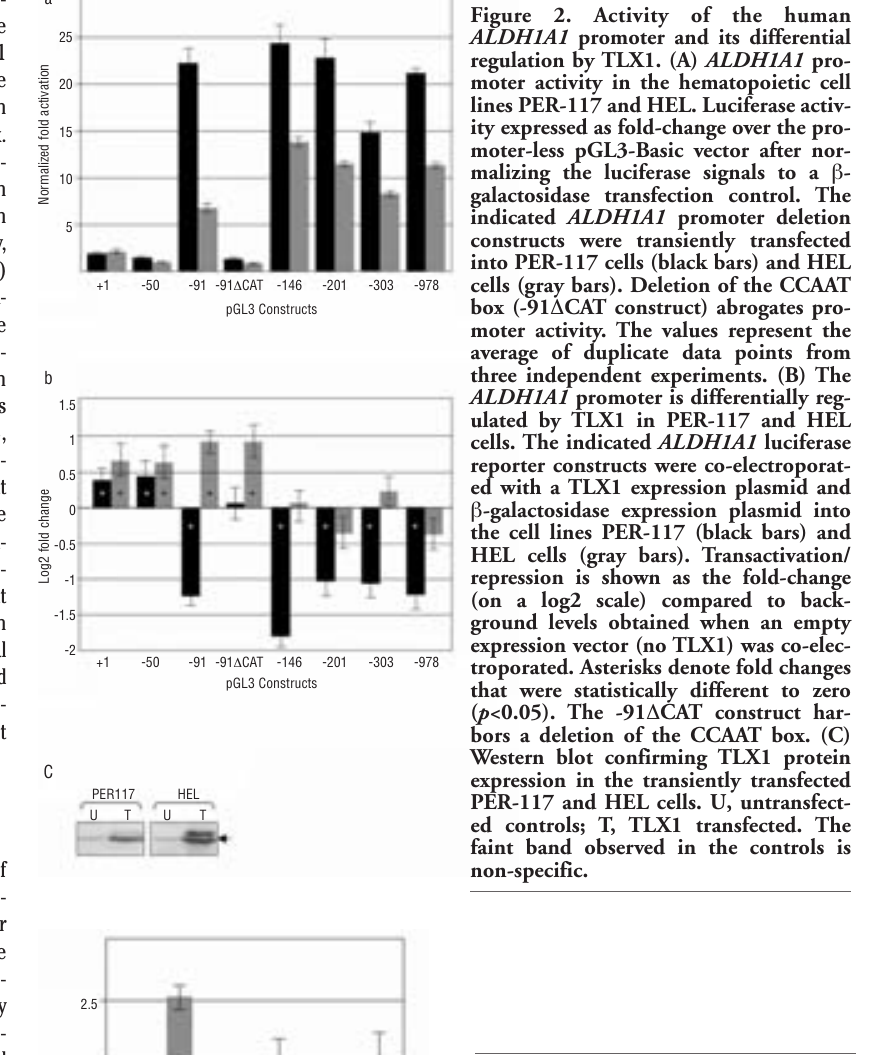
Figure 3. TLX1 requires an intact home- odomain for transcriptional repression but not activation in vitro . Luciferase activity of the ALDH1A1 -91/+42 and FHL1 -821/+181 promoter constructs cotransfected into the indicated cell lines with either an empty expression vector as negative control (striped bars), TLX1 (black bars) or TLX1 Δ H3, a mutant lack- ing helix 3 of the homeodomain (gray bars). The values represent the average of duplicate data points from three inde- pendent